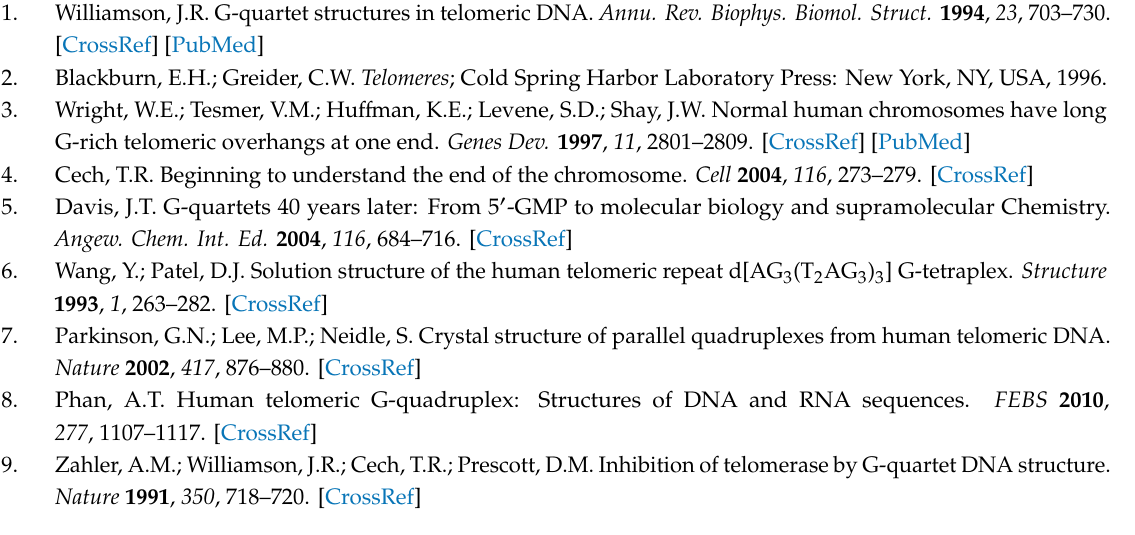
Supplementary Materials: The following are available online. Figure S1. G4 structures unfolded by antisense oligonucleotides in vitro. A) PAGE assays of marker bands of HT24 (T 2 AG 3 ) 4 , HT48 (T 2 AG 3 ) 8 , and HT96 (T 2 AG 3 ) 16 (lane 1) and 40 µ M bcl2-M G4 (lane 2), 40 µ M bcl2-M G4 after overnight addition of 80 µ M anti-bcl2-M (lane 3), 80 µ M anti-bcl2-M (lane 4), 40 µ M CMA G4 (lane 5), 40 µ M CMA G4 after overnight addition of 80 µ M anti-CMA (lane 6), 80 µ M anti-CMA (lane 7), 40 µ M mt9437 G4 (lane 8), 40 µ M mt9437 G4 after overnight